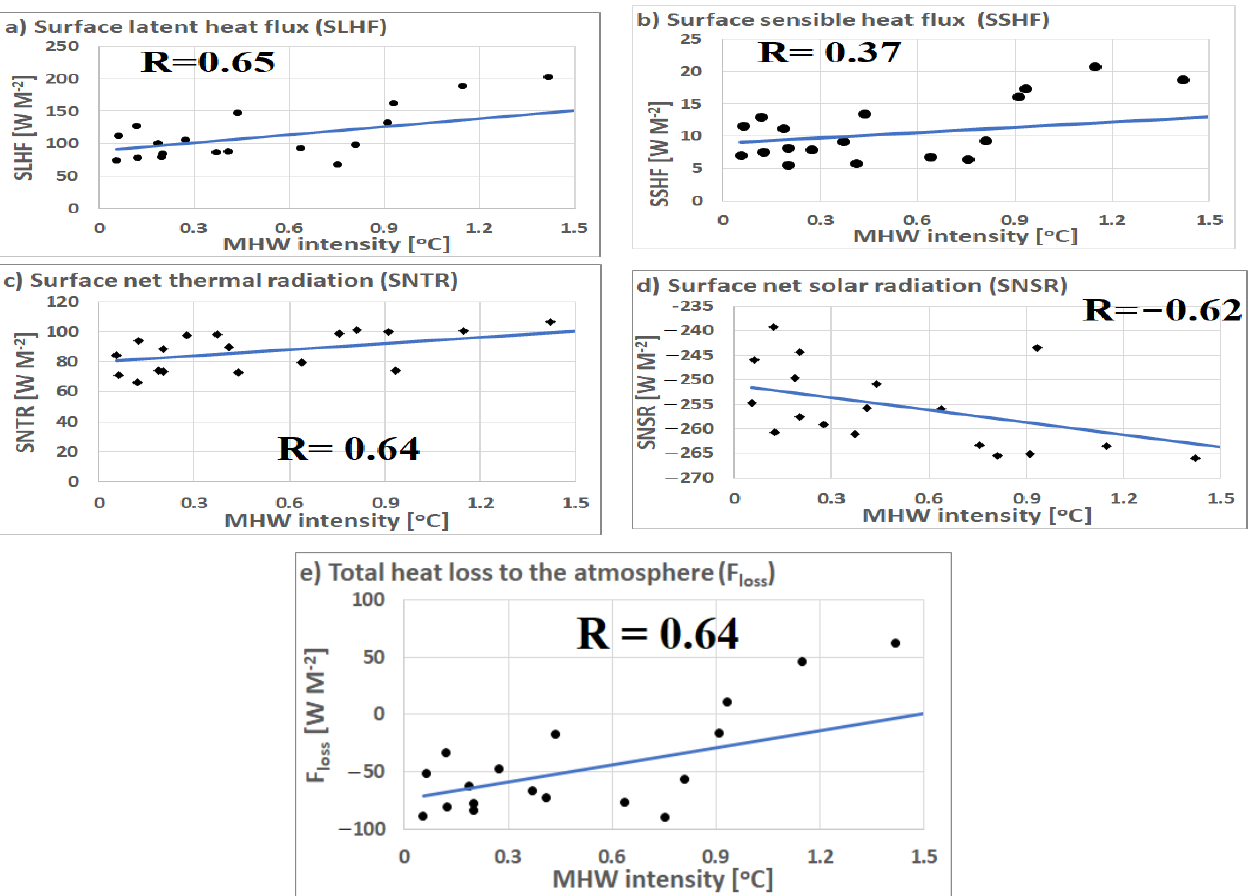
Figure 12. Representative of the MHW event (study case 2 ) showing the sea surface temperature ( a ), intensity [°C] of marine heat wave event ( b ) and category of that event ( c ) at the peak of the event and the time series during the event’s year ( d ), spatially averaged over an area around the maximum intensity grid, which is shown in bubbles.